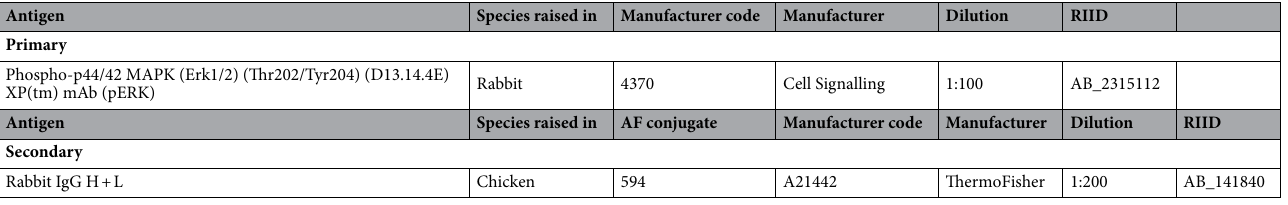
Table 1. Primary and secondary antisera